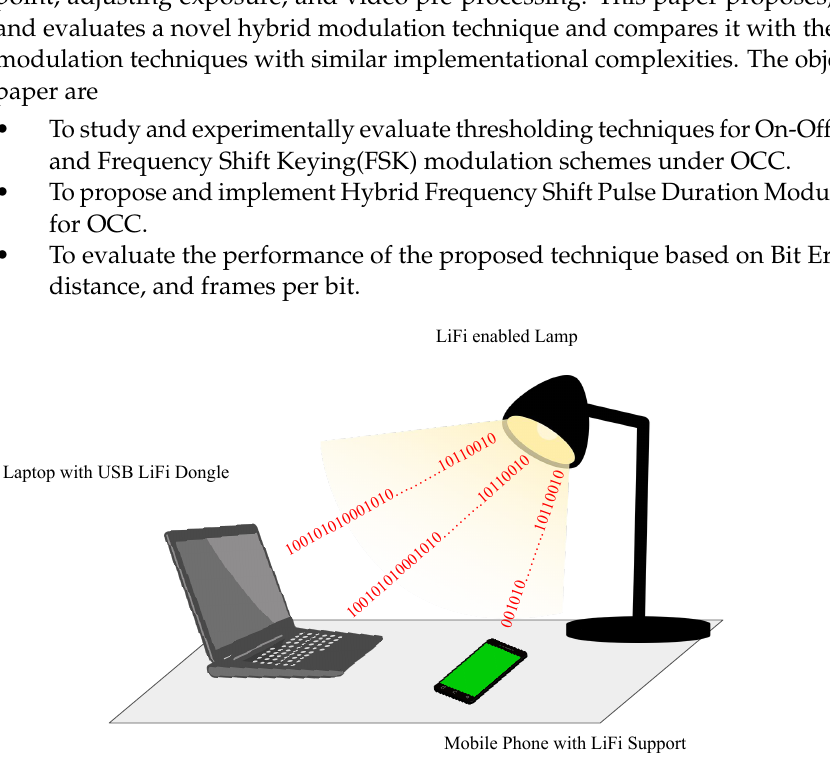
Figure 1. VLC enabled